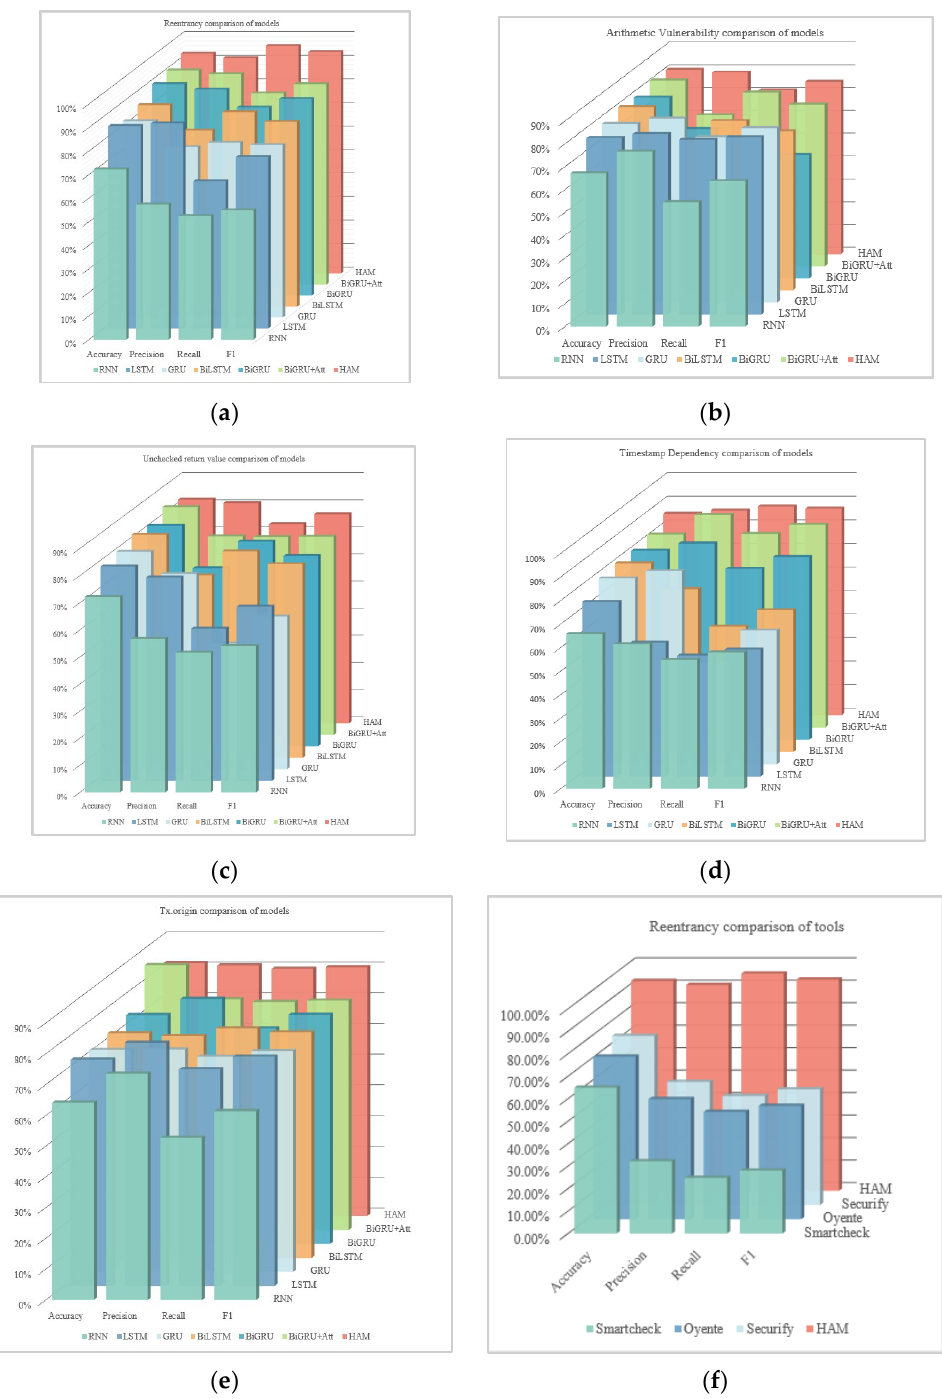
Figure 12. Visualization of the quantitative results: ( a – e ) present comparison results of reentrancy vulnerability, arithmetic vulnerability, unchecked return value, timestamp dependence and tx.origin vulnerability detection, respectively. ( f ) shows comparison results of reentrancy vulnerability detection on Smartcheck, Oyente, and Securify.